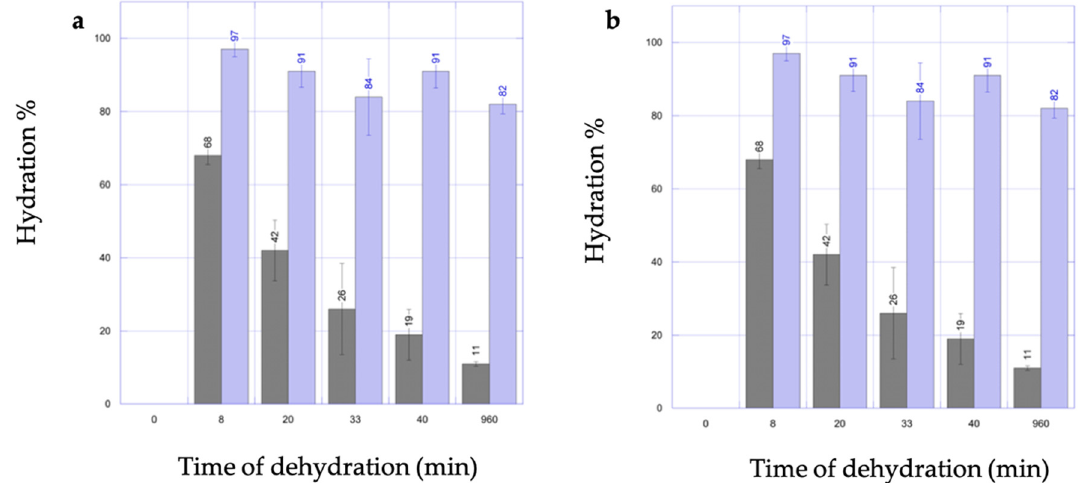
Figure 1. Graphs showing VitE 1 ( a ) or VitE 0.1 ( b ) scaffold rehydration capability. Blue bars indicate hydration status after 1 h of soaking in UP water. Time refers to dehydration in oven. Gray bars = starting dehydration level; blue bars re-hydration level.